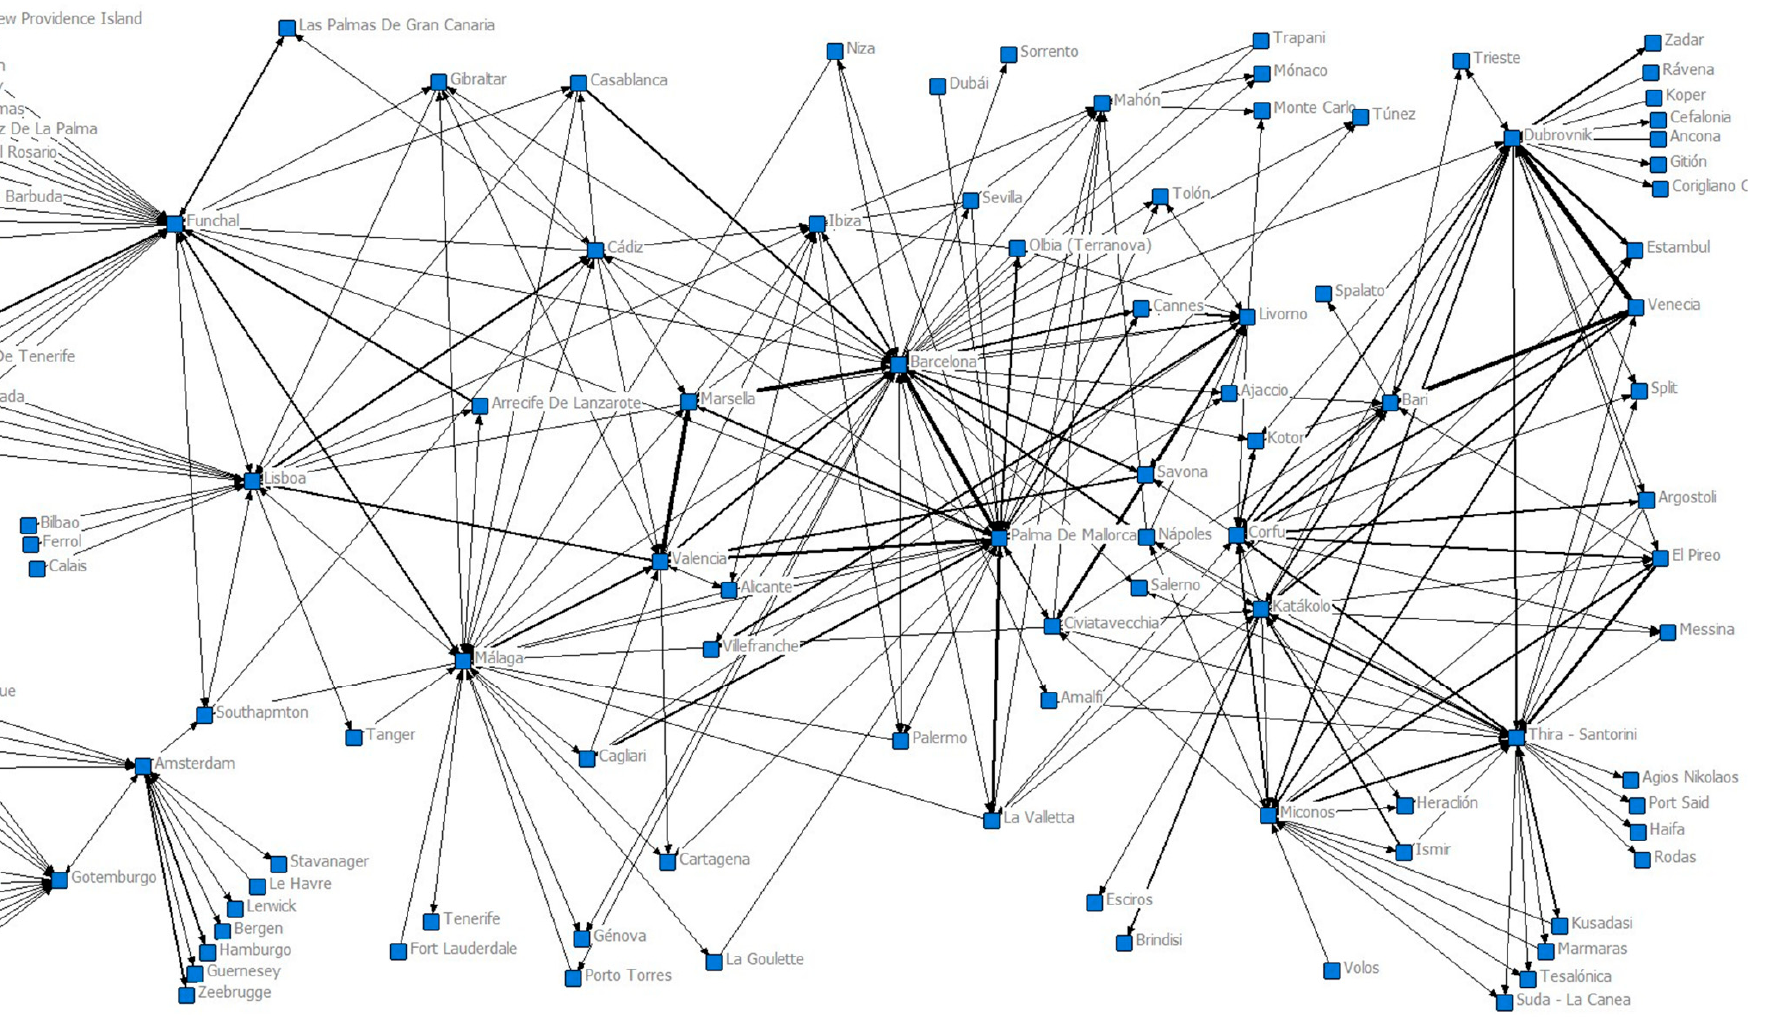
Figure 3. Interrelations in the contemporary cruise port network of Southern Europe in 2015. Source: Authors elaboration. Note: The thickness of the lines indicates the traffic intensity between ports.